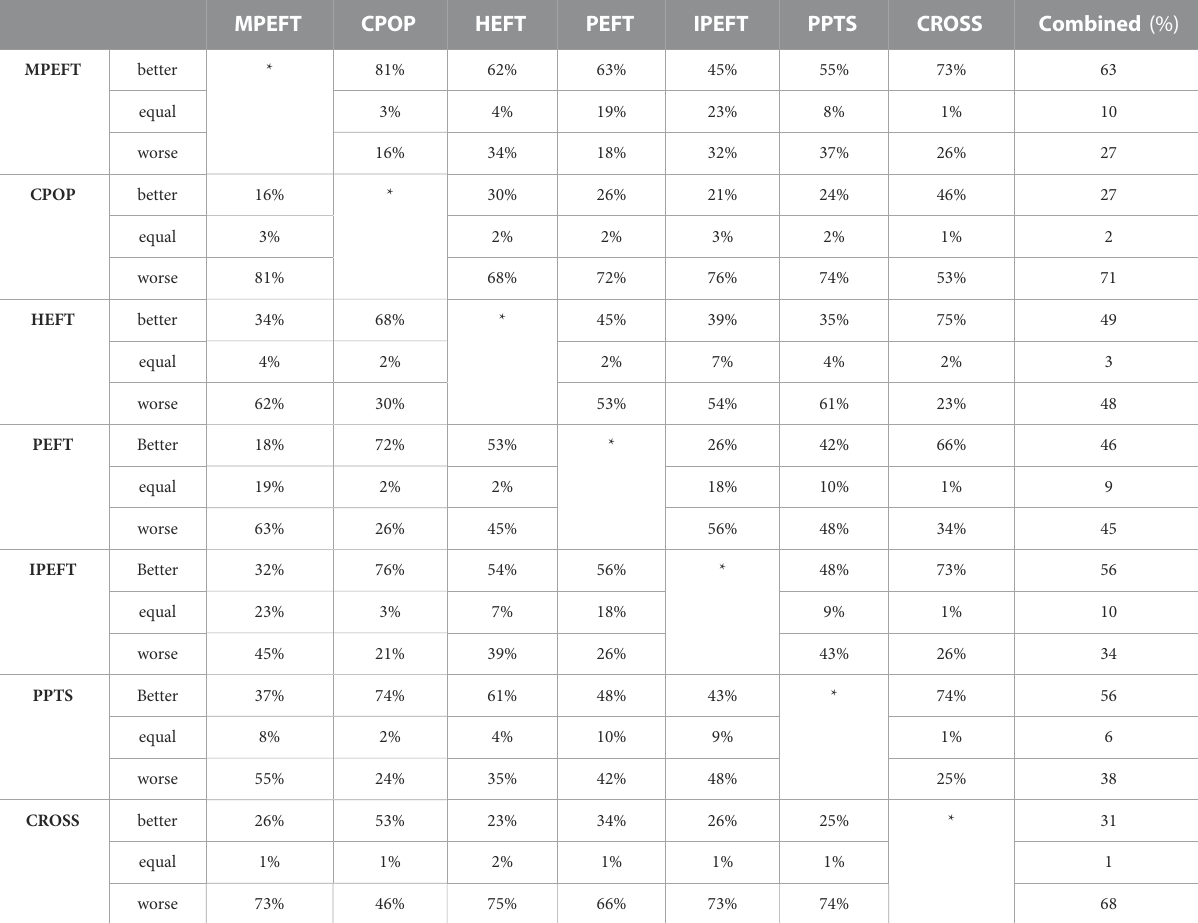
TABLE 6 The NOBQS of the Scheduling Algorithms for random